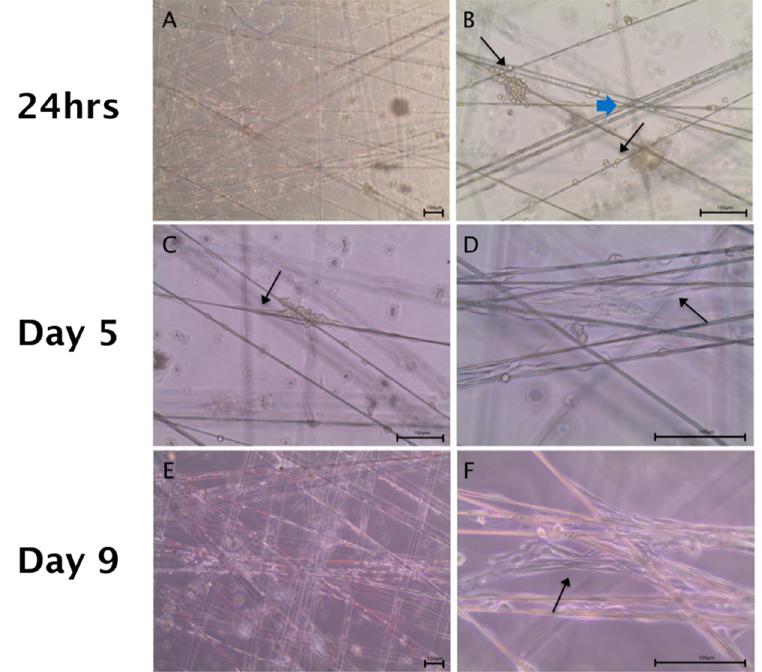
Figure 3. ADSCs and Schwann cells in co-culture on a spider silk scaffold from day 1 to day 9. Scale bars in ( A – F ) represent 100 µm. Bright field images illustrate co-cultures in low ( A , C , E ) and high ( B , D , F ) magnifications, respectively. ( A , B ) On day 1, cell attachment on the silk was observed (indicated by black arrows in B ). ( C , D ) After 5 days in culture, cells had elongated along the silk and accumulated at fiber crossing (indicated by the blue arrow in B ), resulting in a 3-dimensional organization of the cells. ( E , F ) After 9 days, cells were distributed along the silk fibers which were used as guidance structures and started to bridge gaps between the silk fibers (indicated by black arrows in C , D , F ).